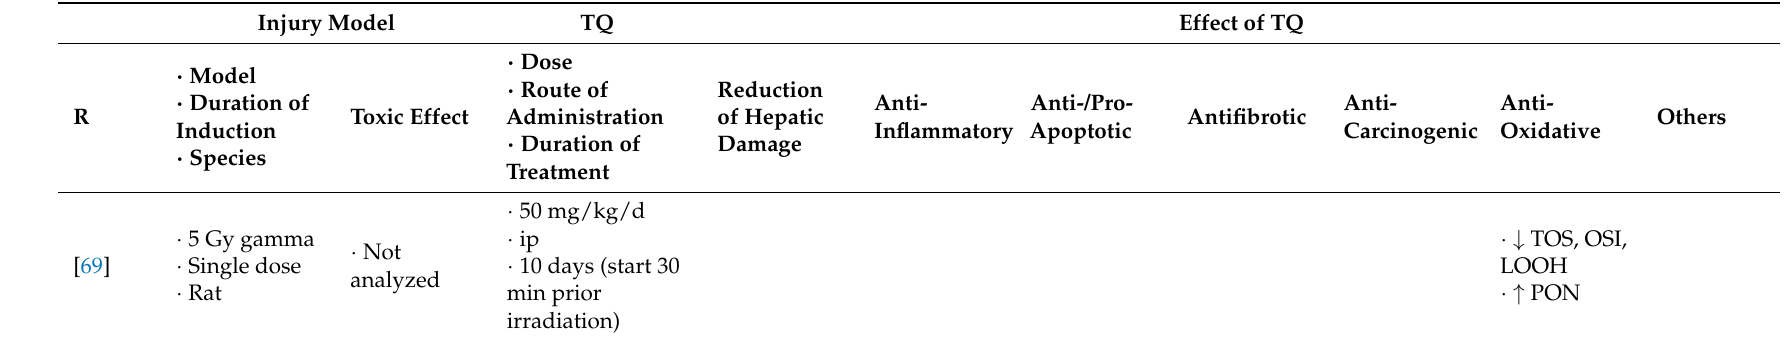
Table 10. Effects on liver injury caused by